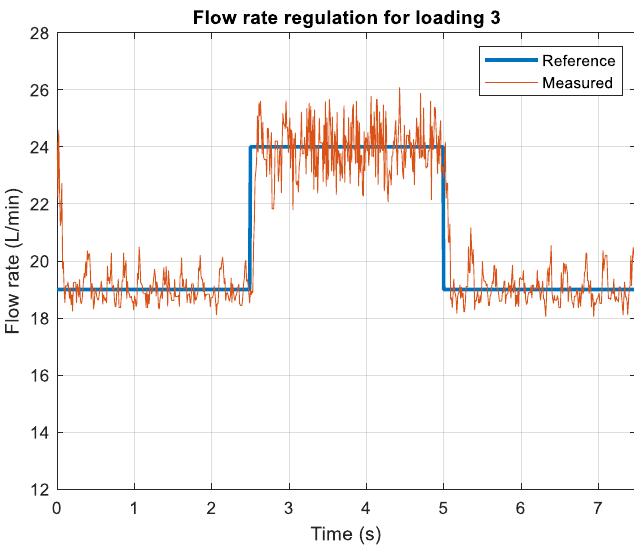
Figure 16. Experimental results for loading condition 3.